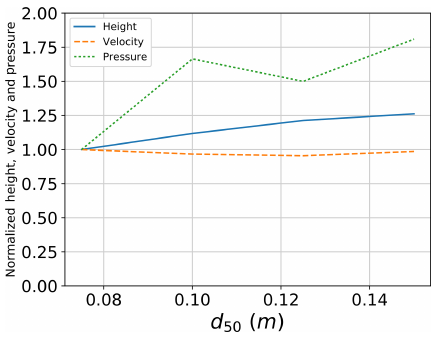
Figure 13. Variation in flow height, velocity and pressure for differ- ent values of mean particle diameter ( d 50 ) when normalized by re- sults of the simulation with φ b = 30 ◦ , and α = 30 ◦